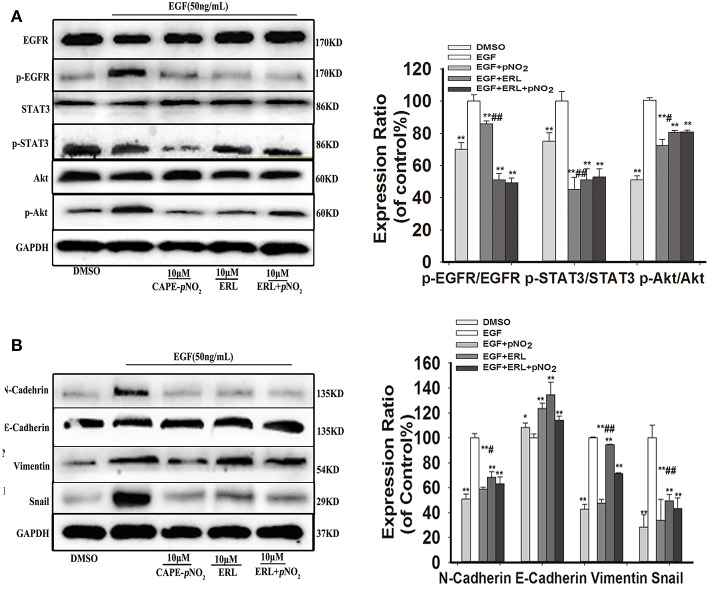
CAPE-pNO2 inhibited the EGF-induced EGFR signaling pathway. Cells were stimulated with 50 ng/ml EGF for 30 min, then replacement of culture medium containing 10 μM erlotinib (ERL) for 12 h, finally replacement of culture medium containing 10 μM CAPE-pNO2 for 24 h. Western blot analysis was performed with related antibodies and quantified by densitometric analysis. (A) The protein expression levels of EGFR, p-EGFR, STAT3, p-STAT3, Akt, and p-Akt. (B) The protein expression levels of EMT-related proteins. The bar graphs show the relative protein expression levels. Values represent the mean ± SD from three independent experiments; *p < 0.05, **p < 0.01: the treated groups compared to the EGF group; #p < 0.05, ##p < 0.01: the CAPE-pNO2 group compared to the ERL+ CAPE-pNO2 group.